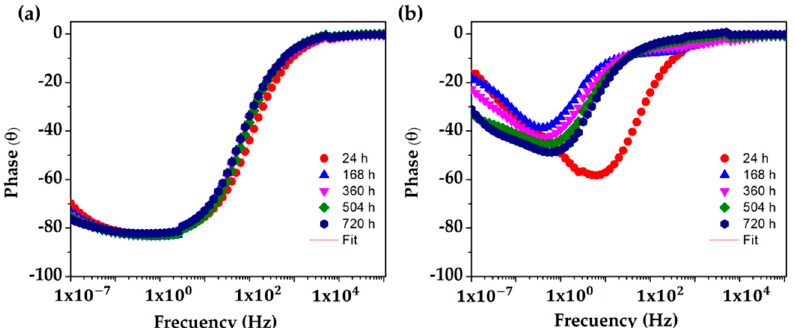
Figure 10. EIS Bode diagrams with a phase angle with a respective fitting line for SS 430 and carbon steel B450C after different times of immersion in cement extract solution (+5 g L − 1 NaCl): ( a ) SS 430, ( b )